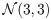
The probability distributions of the background and event A and B pixels.Fig 6a shows the starting distribution of event B pixels distributed as N(3,3) in blue and event A pixels N(4,2) in green. Fig 6b shows the ending distribution of event B pixels N(5,3) in blue and event A pixels N(8,2) in green. In both figures the background pixel distribution N(0,1) is shown in red.